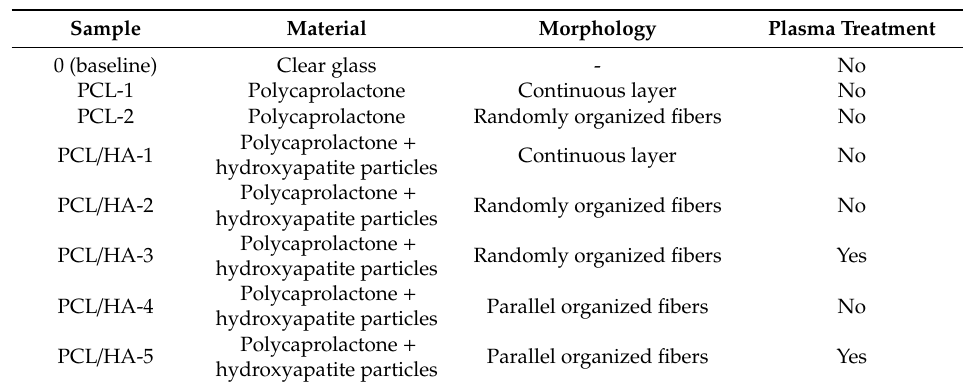
Specification of the samples prepared via electrospinning. HA: hydroxyapatite, PCL: